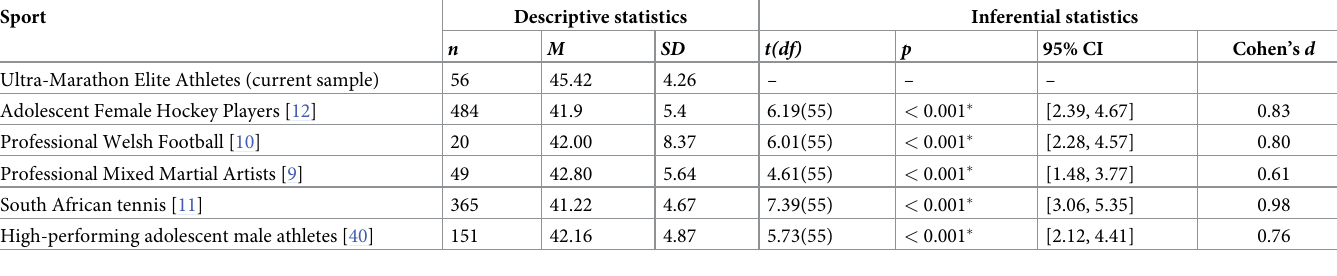
Table 3. Descriptive and inferential statistics for single sample t-tests between current Ultra-Marathon runners sample and previously published SMTQ data for different sports. Sport